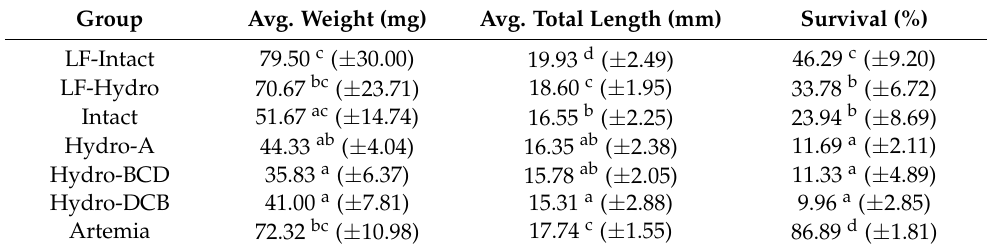
Table 4. Diet effect on growth and